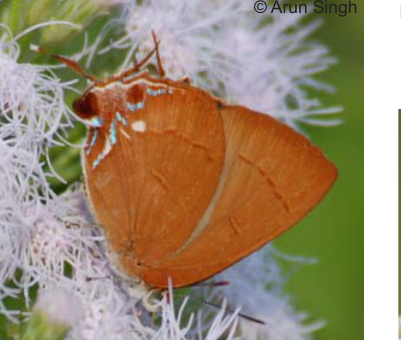
Image 31. Chocolate Tiger Parantica